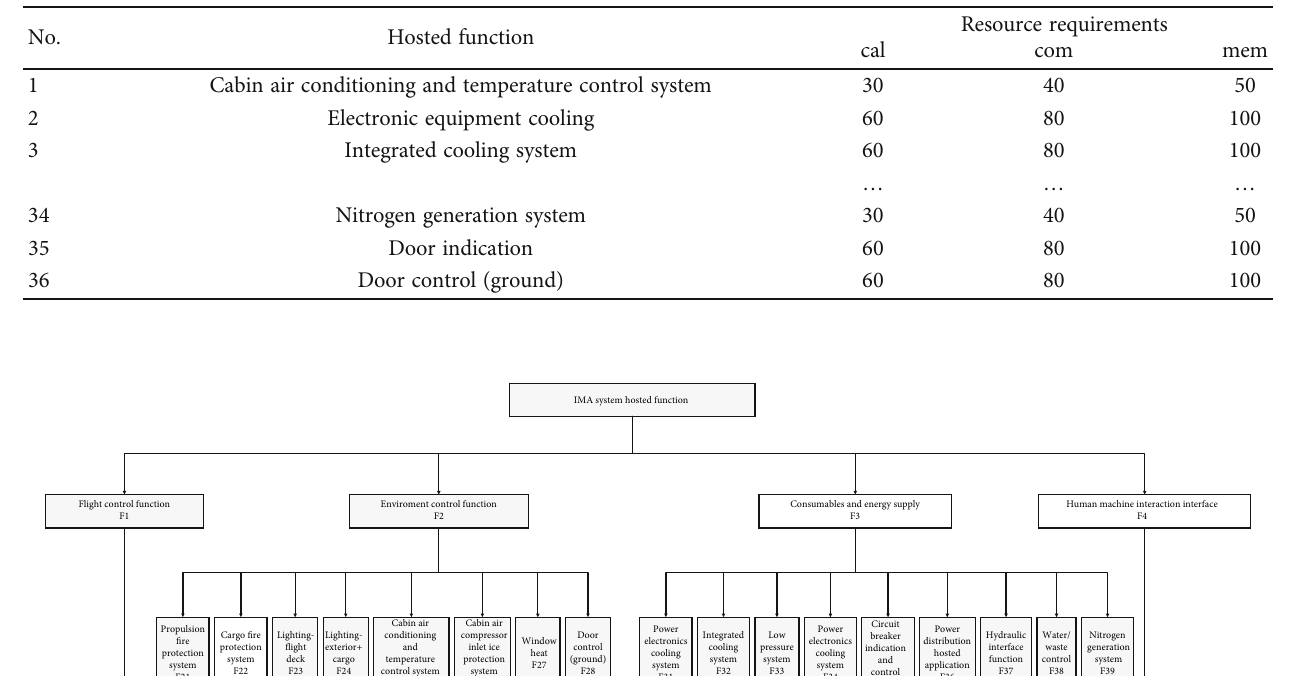
Table 3: Resource requirements of a partial hosted function for B787.